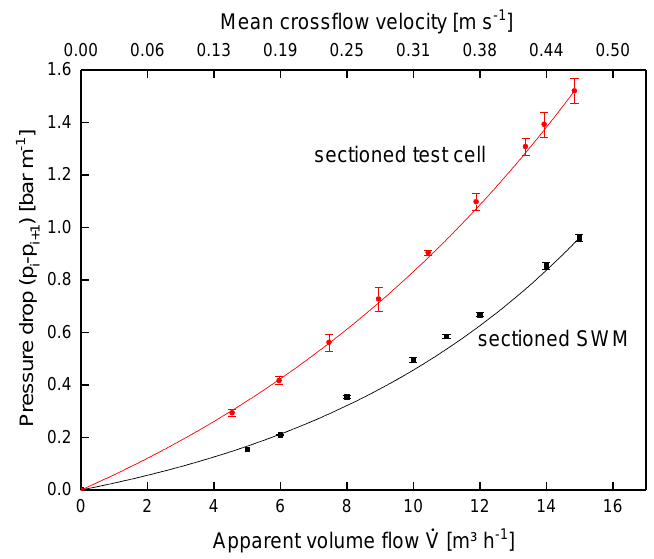
Figure 12. Pressure drop in the sectioned SWM (length of 0.96 m) and the test cell (channel length of 1.00 m) for different volume flows using skim milk.